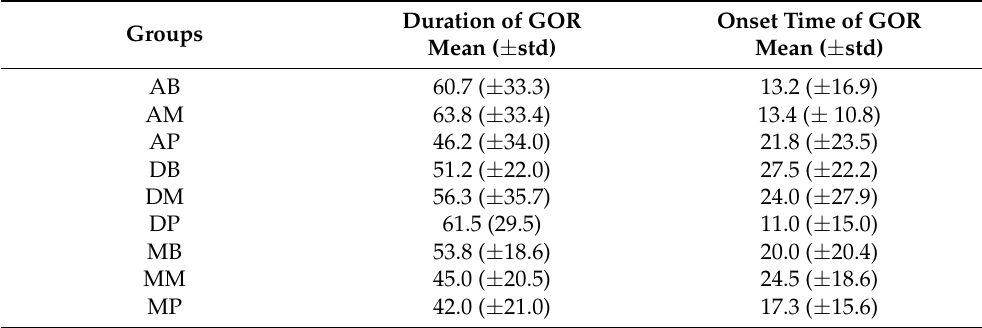
Table 7. The mean ( ± std) duration of GOR and onset time in each of the 9 experimental groups of dogs submitted to esophageal pH-measurement during anesthesia for non-intrabdominal, non- intrathoracic procedures. (n = -30 dogs in each group, 270 dogs in